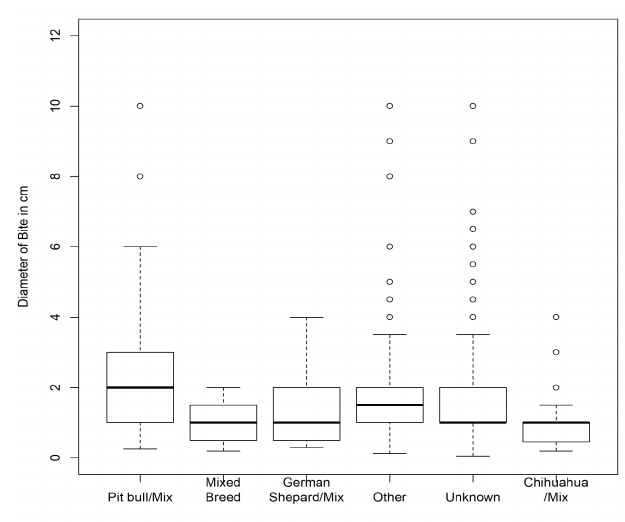
Figure 7. Distribution of bite diameter by breed of